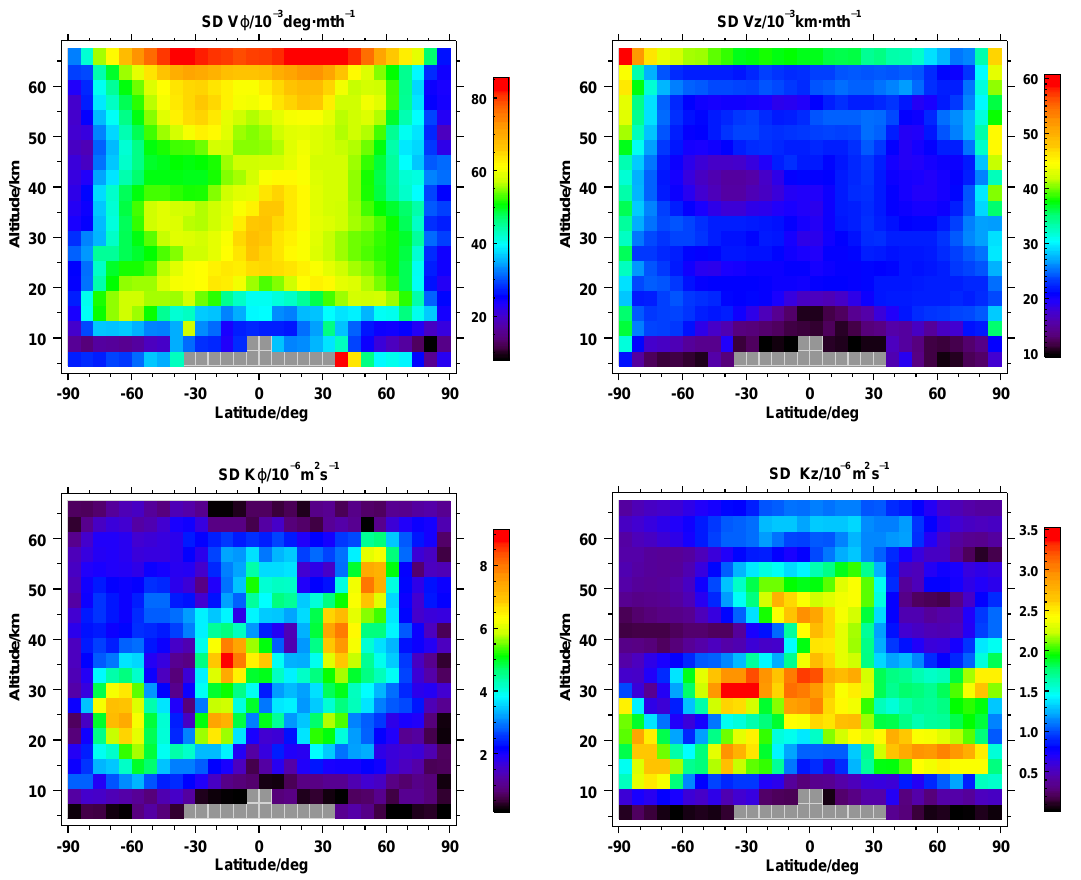
Figure 5. Estimated uncertainties of v(z,φ) (upper left panel), w(z,φ ) (upper right panel), K φ (lower left panel), and K z (lower right